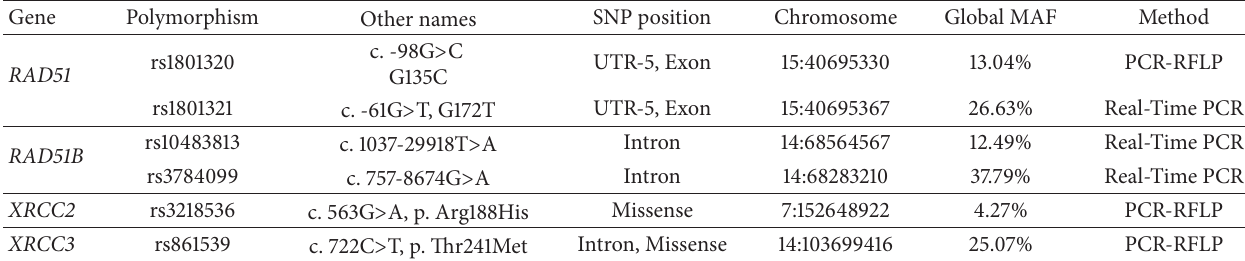
Table 2: SNPs analyzed.